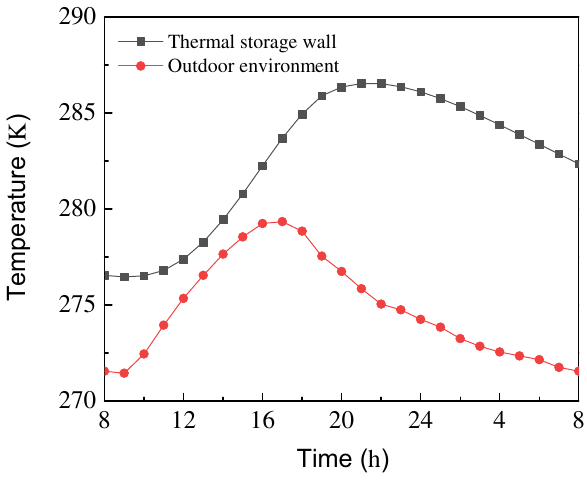
Figure 9. The average temperature change of the thermal storage wall with